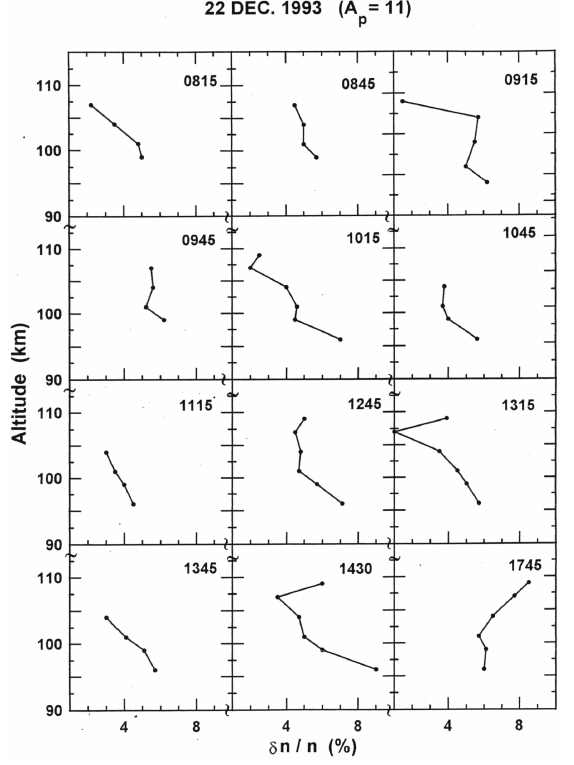
Fig. 2. Deduced altitude profiles of δ n/n corresponding to the times shown in Fig. 1.